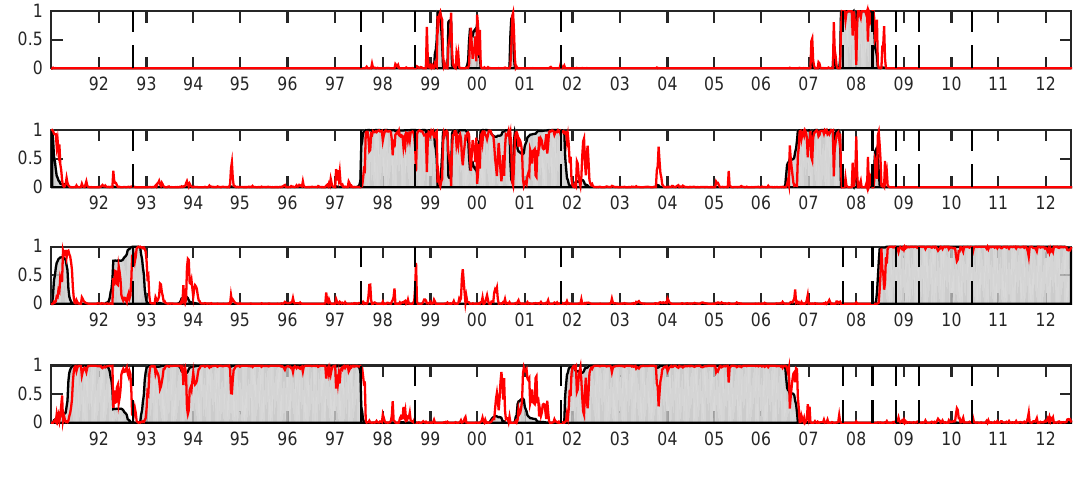
Figure 3. Smoothed probabilities of visiting the states of the Markovian chain P ( S = j | I ) for j = 1 ; : : : ; 4 and t = 1 ; 2 ; : : : ; T (from top to bottom) implied by the t T Student- t model with four components. The superimposed red lines represent the predictive = j | I ) for j = 1 ; : : : ; 4 and t = 1 ; 2 ; : : : ; T . States 1 and 4 probabilities P ( S t t (cid:0) 1 are identified as periods of financial turbulence and stability, respectively, while States 2 and 3 are regimes where the financial system transits just before or immediately after a crisis period. Vertical dotted lines represent major financial downturns: see Figure 1 for a detailed